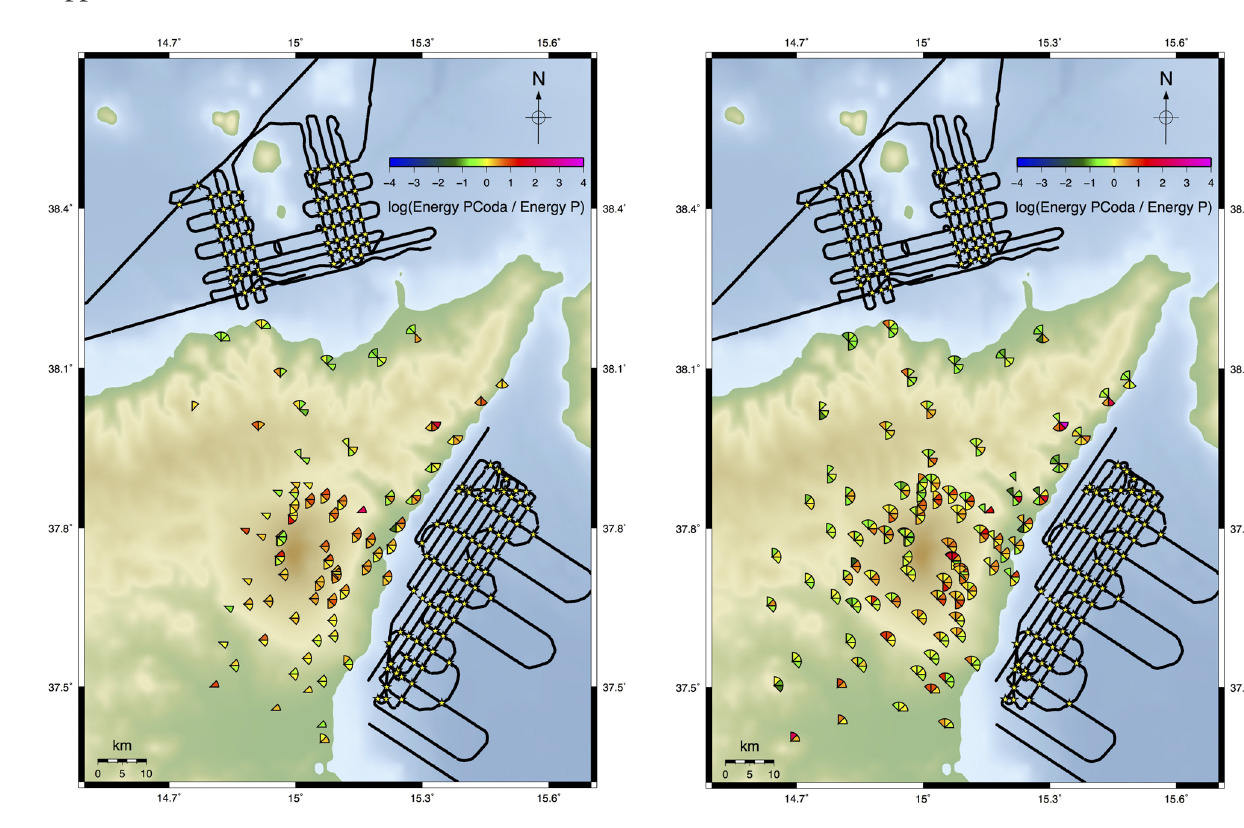
Figure A2. Energy ratio depending on the back azimuth with short time windows (see text). Each pie wedge is calculated from least 5 values for averaging. Green respectively blue colors symbolize a low ratio, yellow respectively red colors symbolize a high